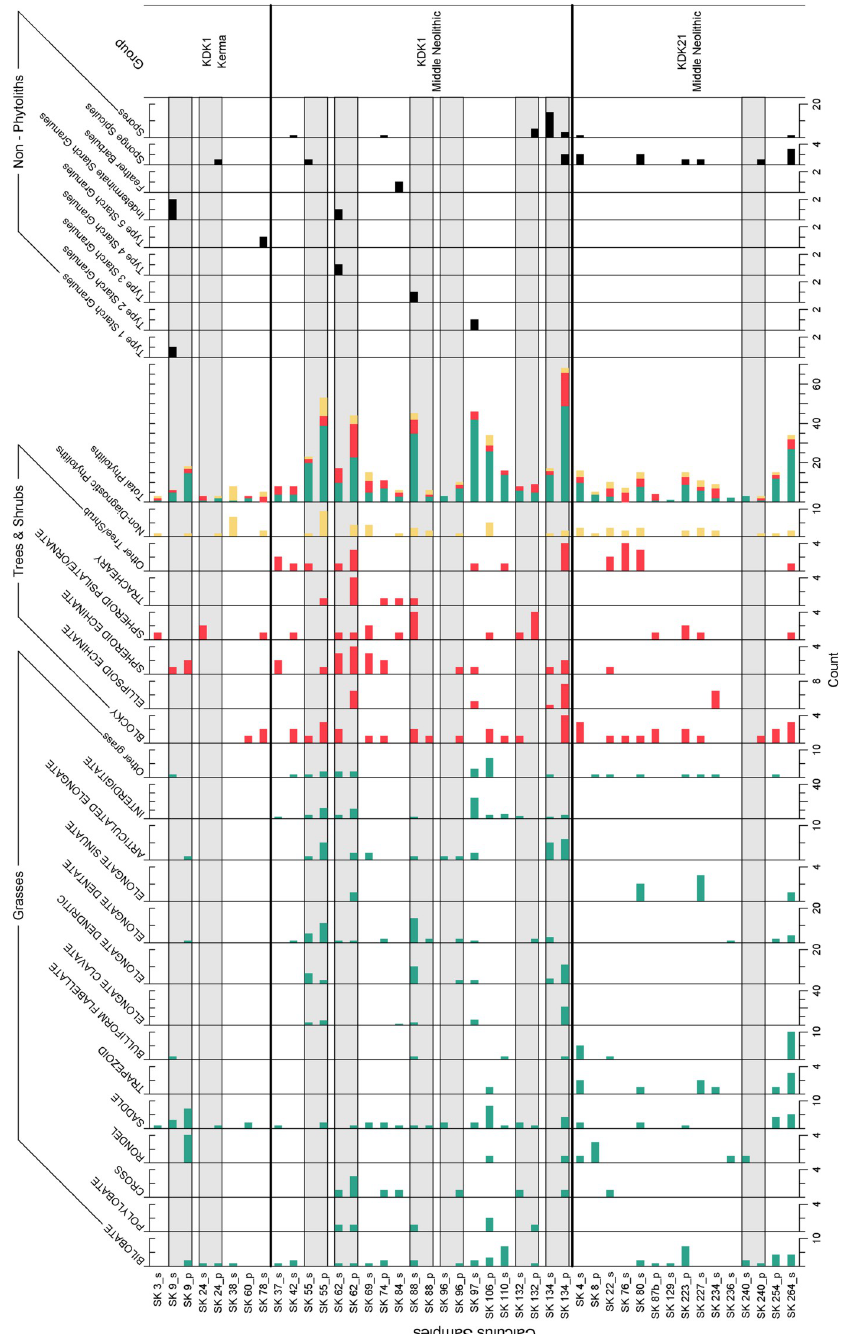
Fig 5. Summary of microparticles recovered from KDK1 and KDK21 dental calculus. Count data from 34 individuals with preserved microparticles. Samples are arranged according to site and chronological phase (‘Group’). Sample suffix _s indicates solid calculus, _p indicates powder calculus. Individual calculus samples with corresponding solid and powder fractions are indicated with shading for comparison of microparticle diversity/density.